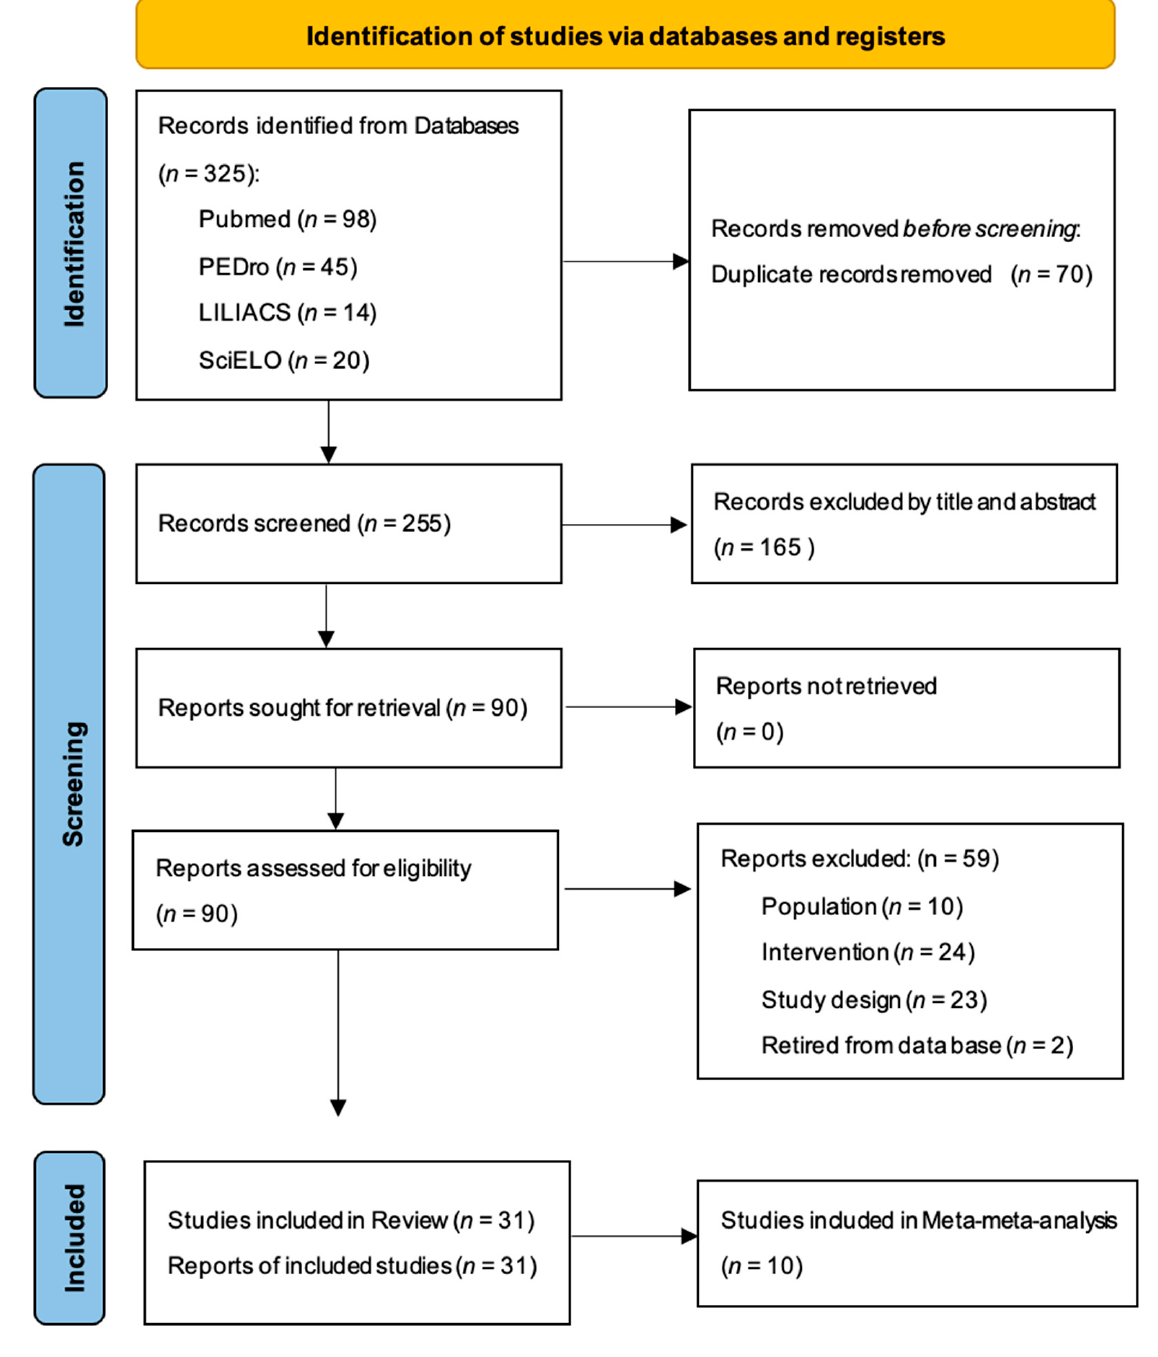
Figure 1. Flow chart of the research screening process.